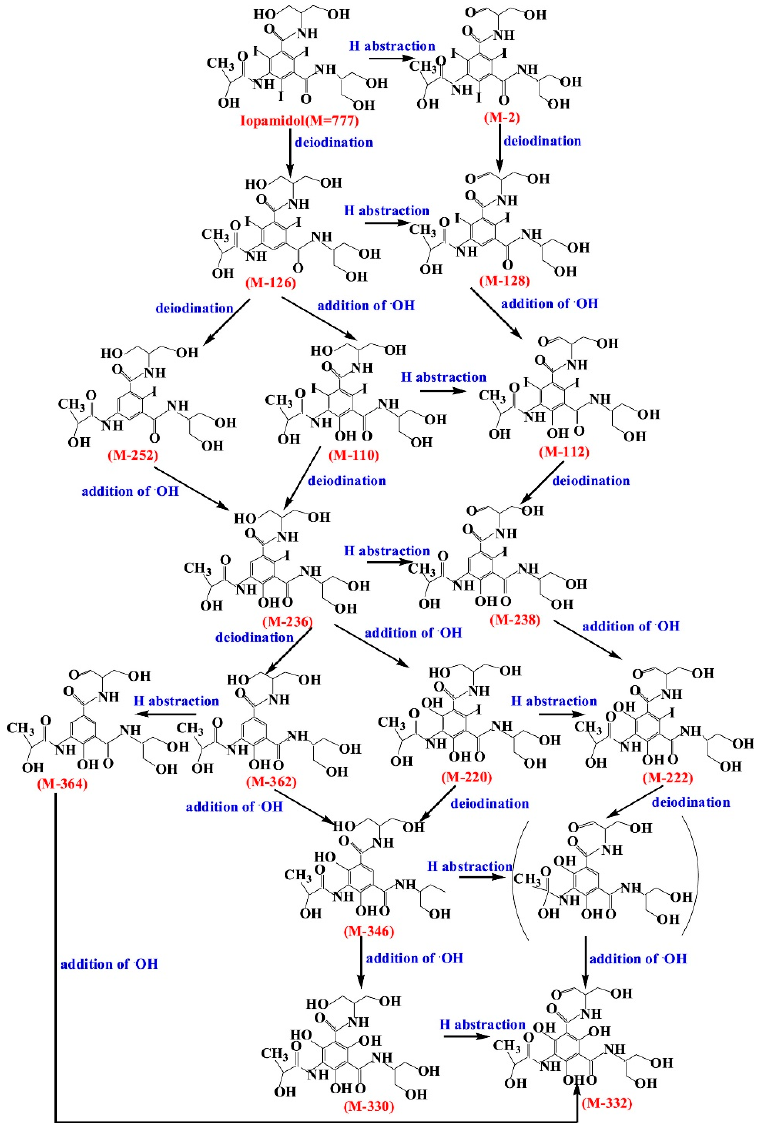
Figure 3. Proposed destruction pathways of iopamidol during UV irradiation [85]. Reprinted from ref [85] , Copyright 2014, with permission from Elsevier.